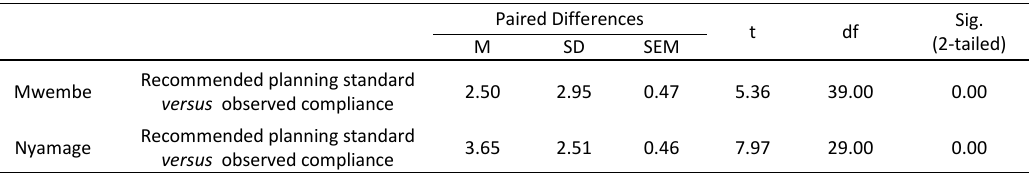
Table 5: Paired sample test on car parking, Mwembe and Nyamage